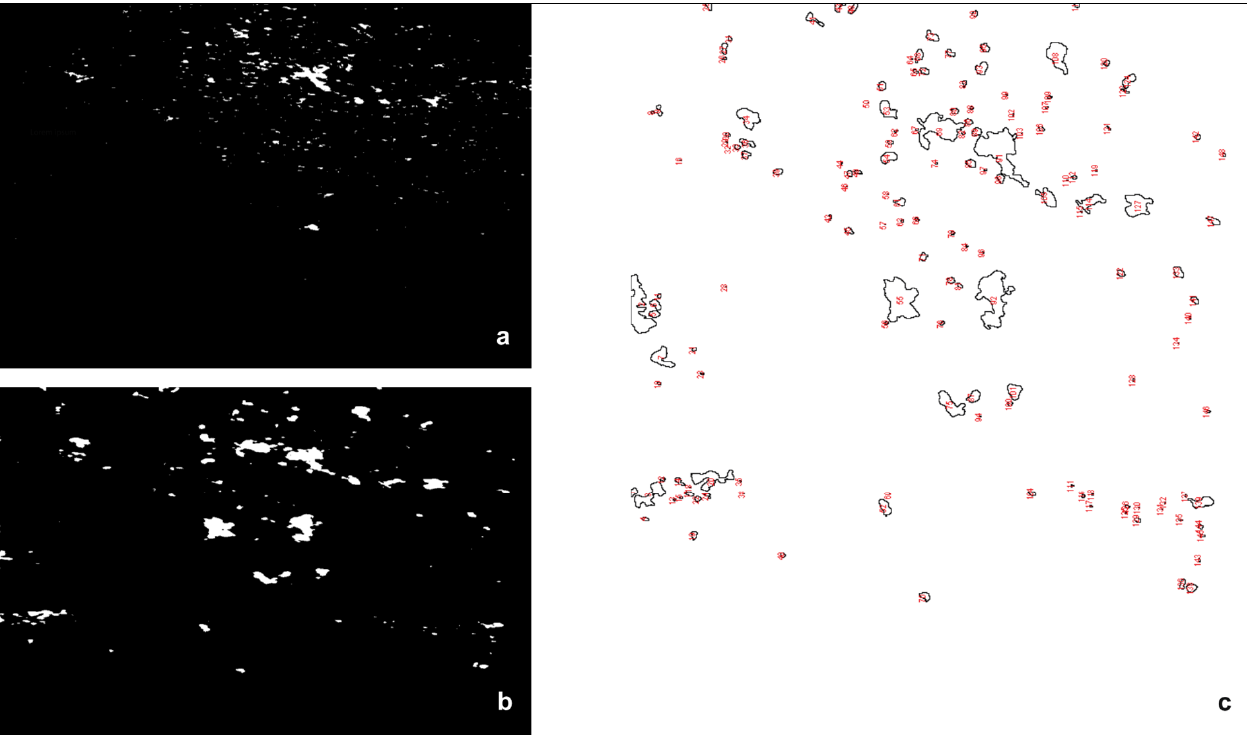
Figure 8. The increase in pore area (%) as a function of acidizing temperature.